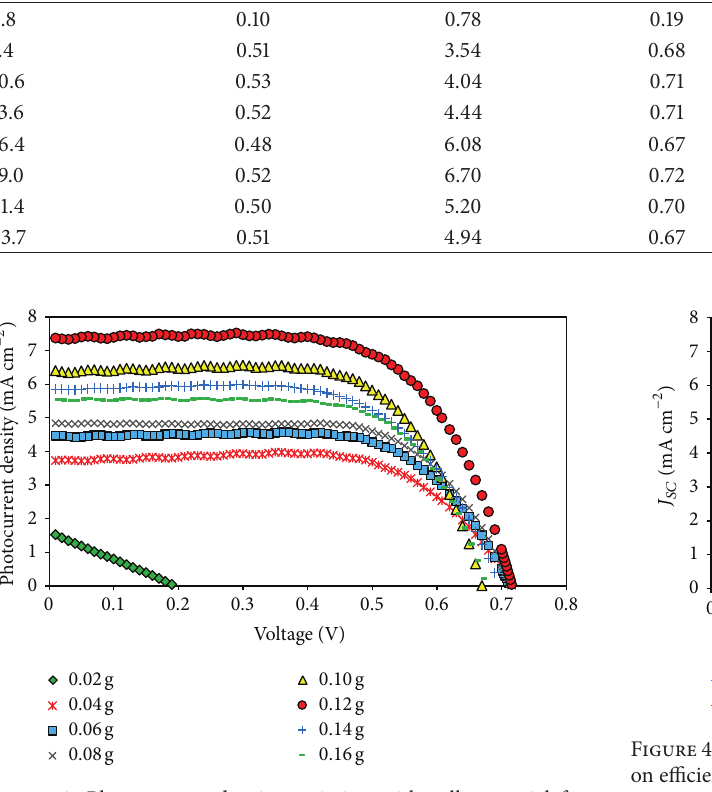
Figure 3: Photocurrent density variation with cell potential for dye-sensitized solarcells having phthaloylchitosan-based electrolyte with various Pr 4 NI/I 2 contents.